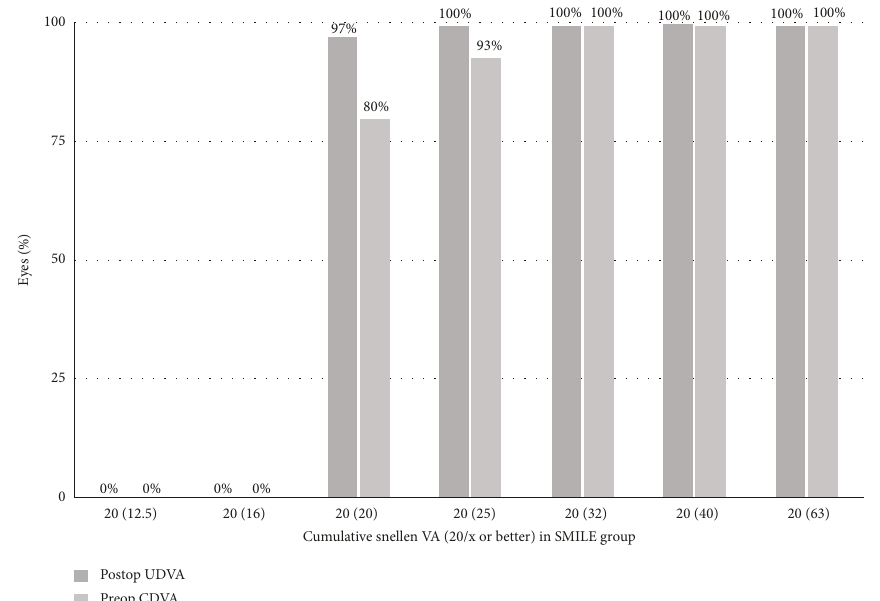
Figure 4: Cumulative Snellen visual acuity in SMILE Xtra group: preop CDVA and post